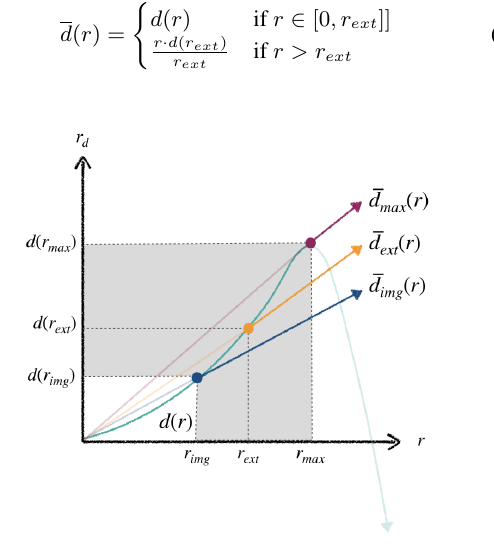
Figure 5. Example of the behavior of the radial distortion model. d img ( r ) , d ext ( r ) , d max ( r ) show three possible